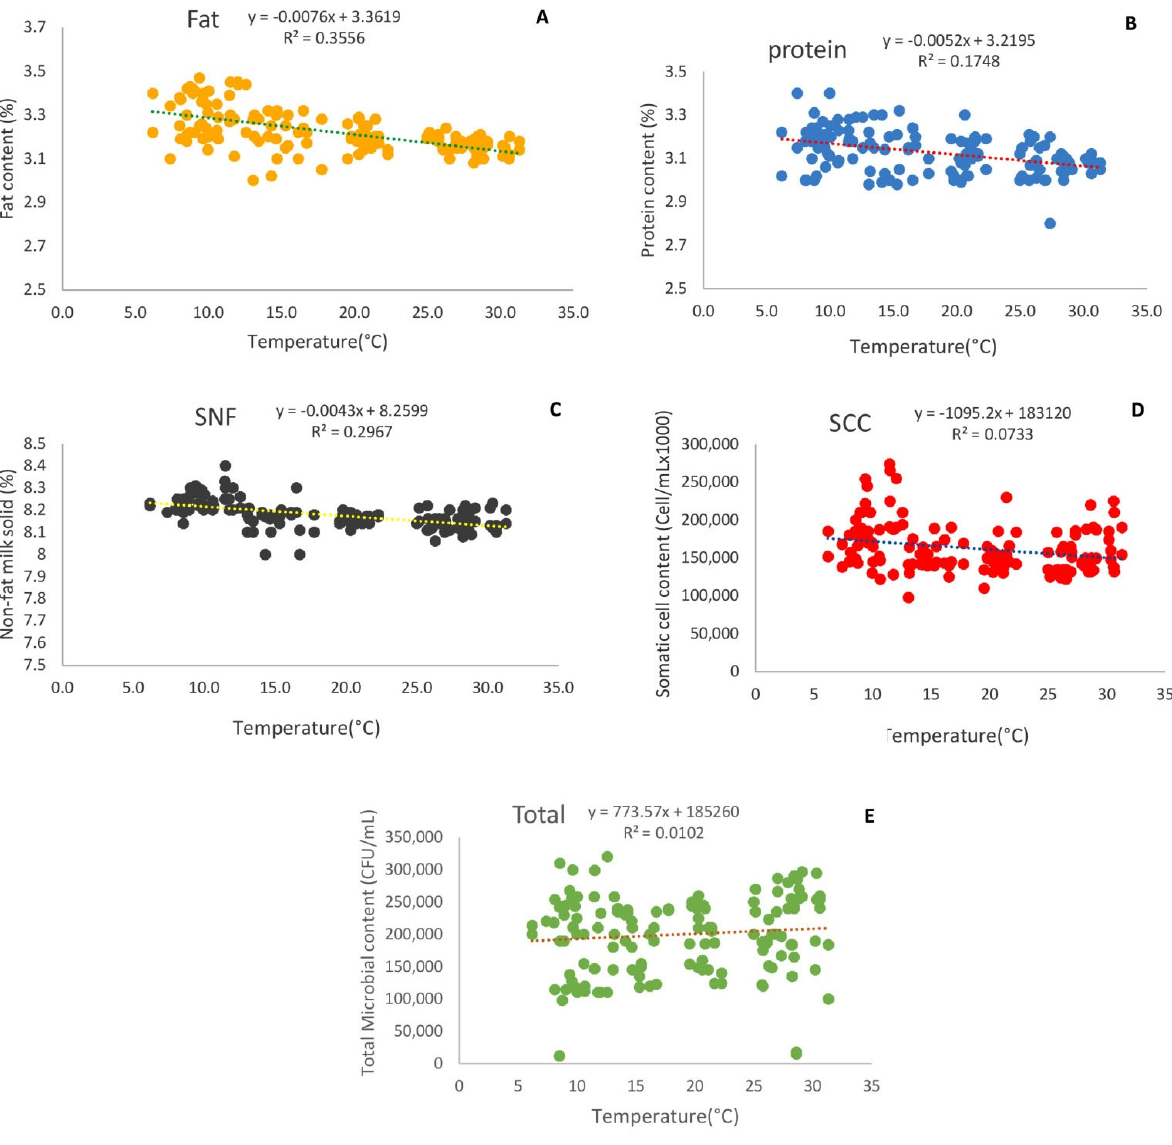
Figure 2. Effect of environmental temperature on fat ( A ), protein ( B ), non ‐ fat solids ( C ), somatic cell count ( D ), and total microbial count in milk ( E ). count ( D ), and total microbial count in milk ( E